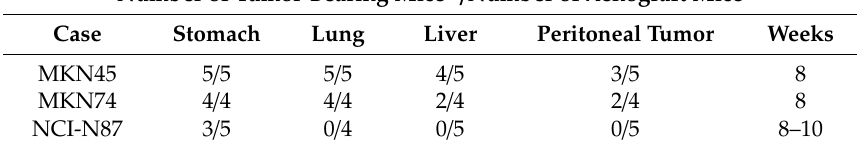
Figure 2. Detection of gastric tumors and distant micrometastases and macrometastases by immunohistochemistry in orthotopic xenograft mice. Representative images of HLA detection by immunohistochemistry on stomach tumors and lung and liver metastases formed with MKN45 cells ( A ) and GC10 PDX case ( B ) eight and 10 weeks after orthotopic xenograft, respectively. The enlarged pictures in the lower panel show the HLA-positive gastric adenocarcinoma (GC) cells in the stomach, lung, and liver metastases. Scale bars: 2 mm in the upper panel, 200 µm in the lower panel. Table 2. Number of tumor-bearing mice per total of NSG mice implanted with gastric cancer cell lines into gastric subserosa.